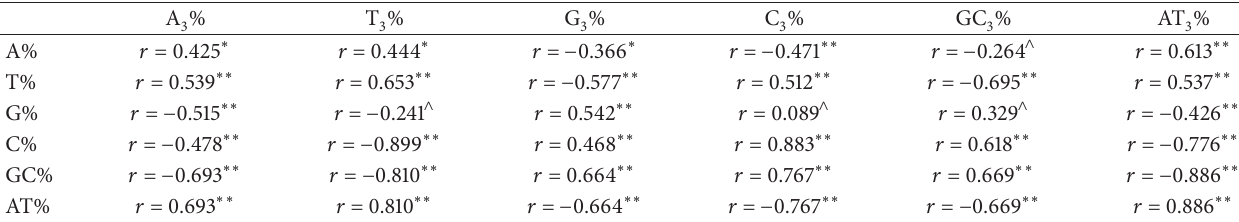
Table 2: Correlation between different nucleotide compositional parameters.